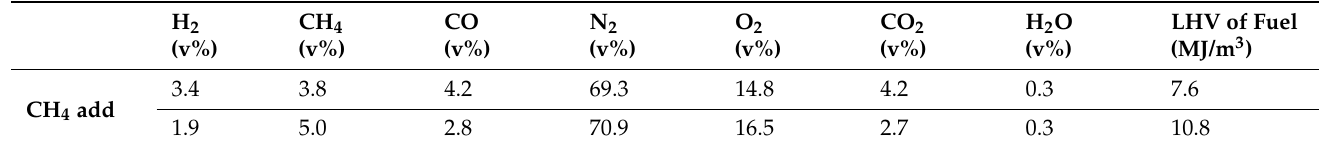
Table 4. The mixture in a cylinder with H 2 addition. Two conditions are used.